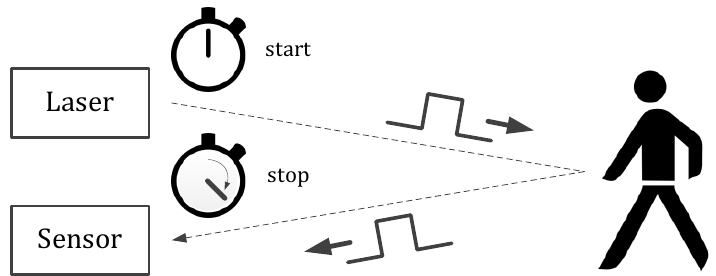
Figure 1. Operation principle of the direct time-of-flight measurement technique. By a high precision electronical stopwatch the time between emission and reception of a short laser pulse is captured.